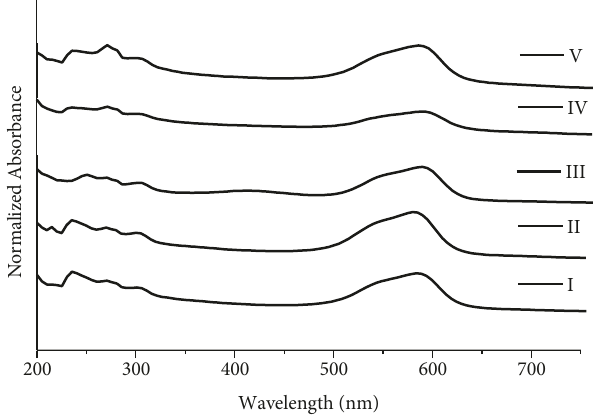
Figure 2: UV/Vis spectra for groups I, II, III, IV, and V of black ballpoint pen inks.